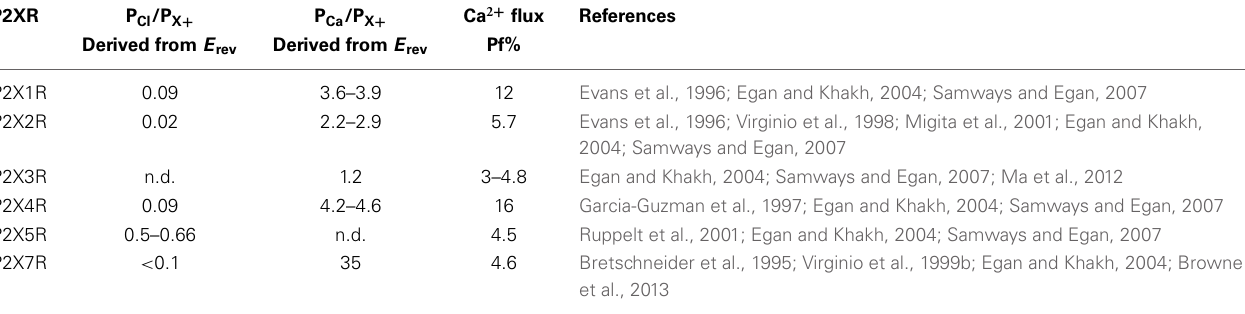
Table 1 | Relative permeability and fractional Ca 2 + current (Pf%) data for recombinant homomeric